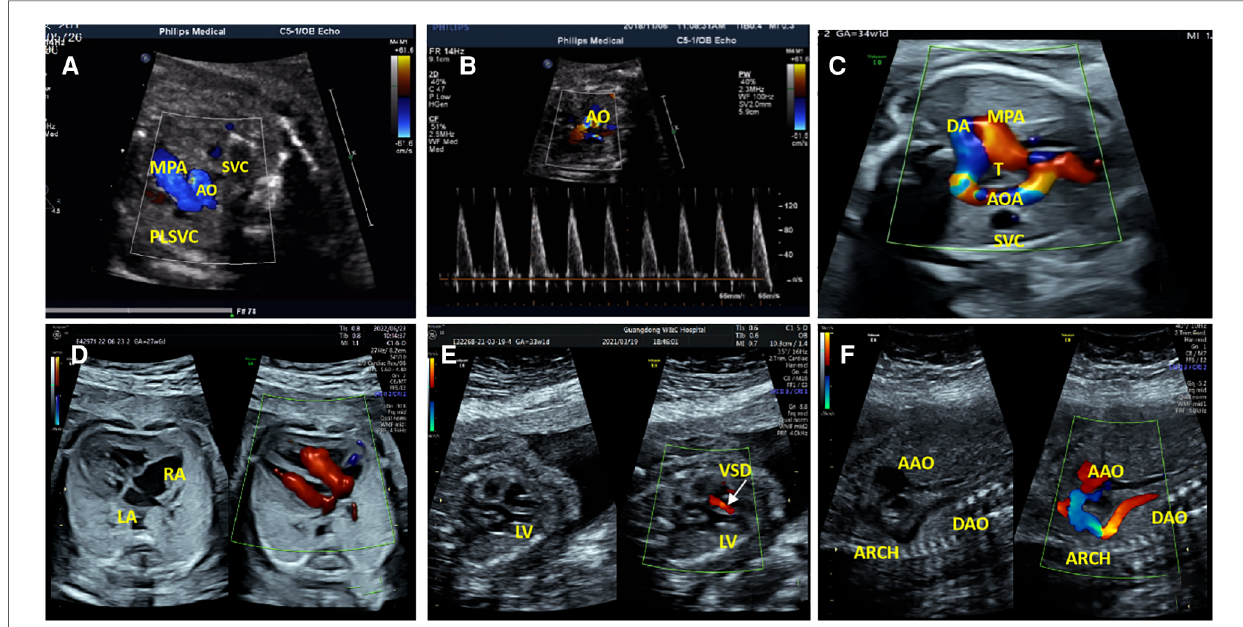
FIGURE 1 The most common cardiovascular abnormalities in our study. ( A ) The ultrasound examination of case 1 showed a small additional vessel found at the main pulmonary artery (MPA) left in the three-vessel view. SVC, Superior Vena Cava; AO, Aorta; PLSVC, Persistent Left Superior Vena Cava. ( B )The color Doppler ultrasonic images of case 1 in the left ventricular out fl ow tract view showed elevated blood fl ow rate of the aortic valve. ( C )The ultrasonic examination of case 7 showed that the aortic arch was on the right side of the trachea ( T ), the MPA was on the left side of the T, and they constituted U-shaped ring of blood vessels at the three-vessel view. AOA, Aortic Arch; DA, Ductus Arteriosus. ( D ) Two-dimensional and color Doppler ultrasonic images of case 9 showed enlargement of the right atrium (RA) in the four-chamber view. ( E )Two-dimensional and color Doppler ultrasonic images of case 14 showed left ventricular septal defect (VSD), and left-to-right shunt of defect part (color Doppler fl ow signal at the defect) in the left ventricular out fl ow tract view. LV, Left Ventricle. ( F ) Two-dimensional and color Doppler ultrasonic images of case 14 showed that the descending aortic arch extends to the left obviously in the long axis of the aortic arch view. AAO, Ascending Aorta; DAO, Descending